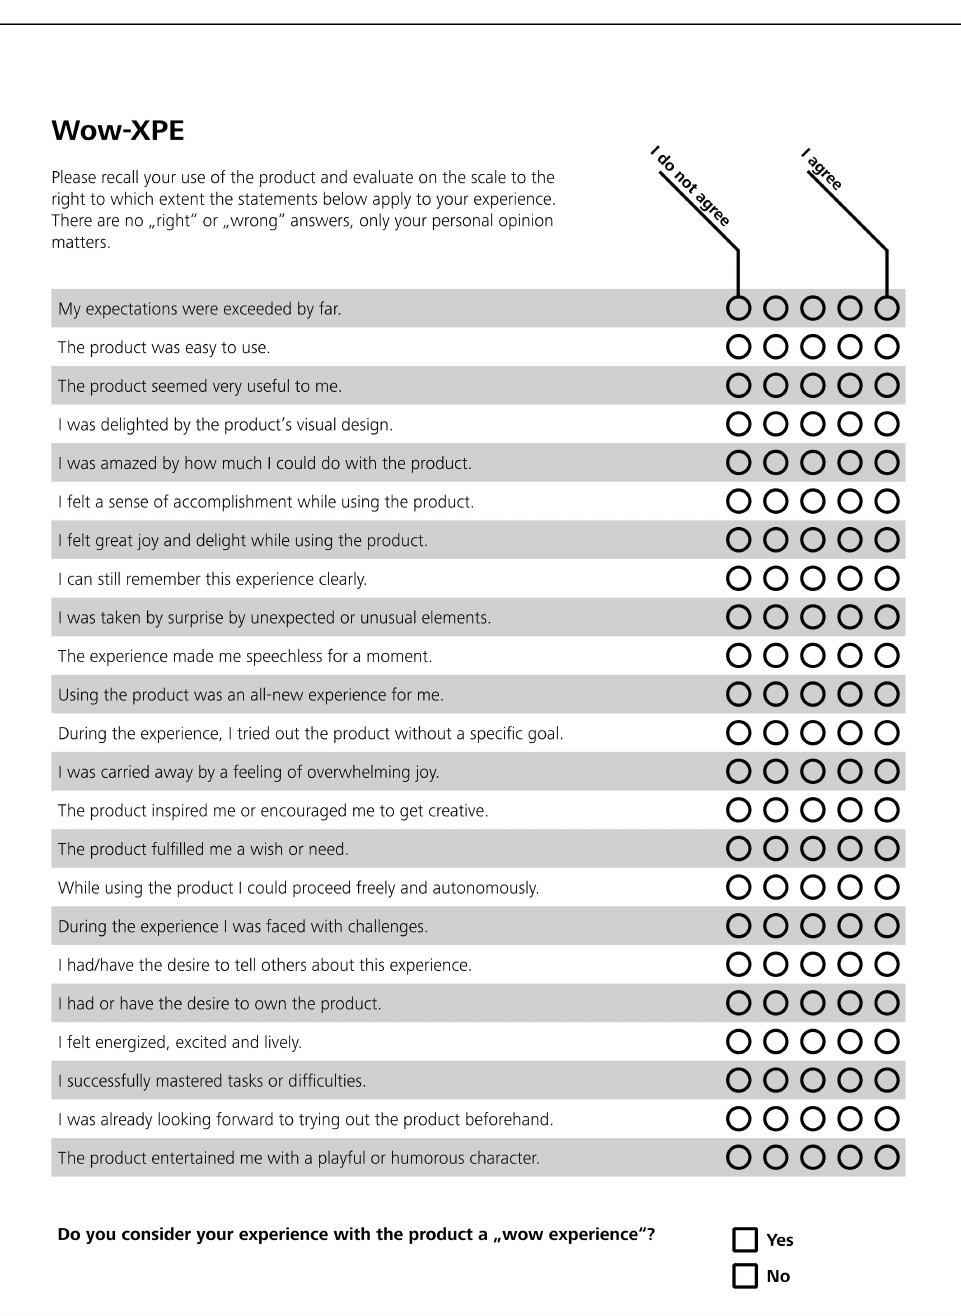
Figure A1. Wow-XPE (Wow experience performance evaluation) prototype